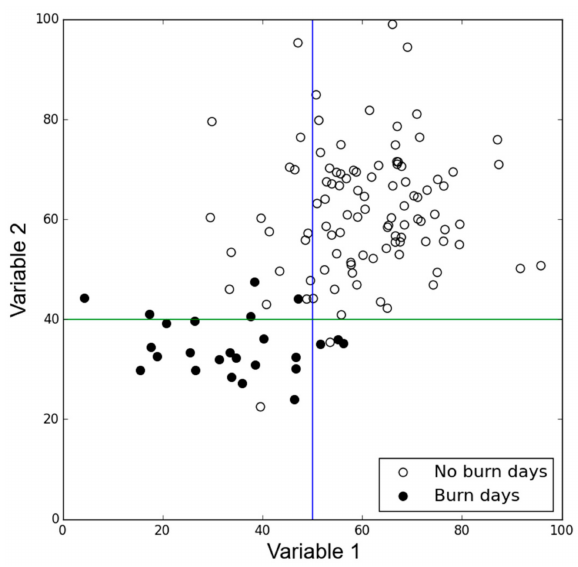
Figure A2. Decision boundaries created by the Classification and Regression Tree (CART) algorithm to classify the data using variable 1 and variable 2.